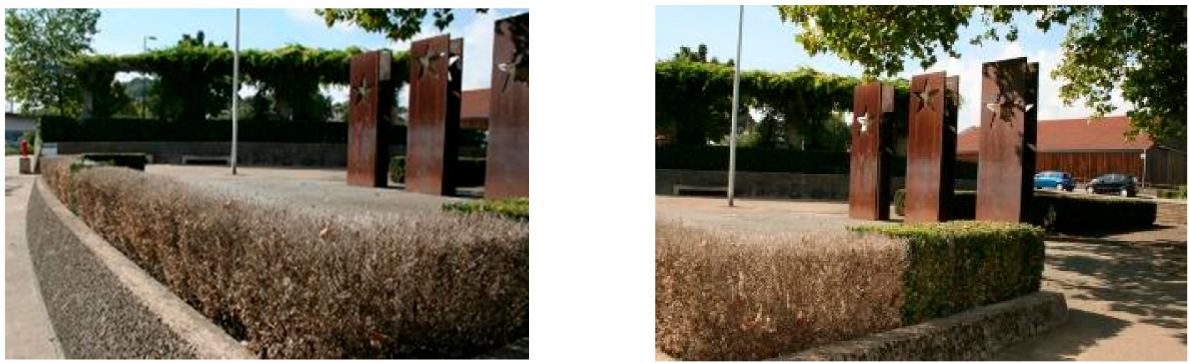
Figure 1. “Twist of fate”—a boxwood hedge in front of the European Museum in Schengen, damaged by an East Asian invasive box tree moth (September 2019). Photo: M.